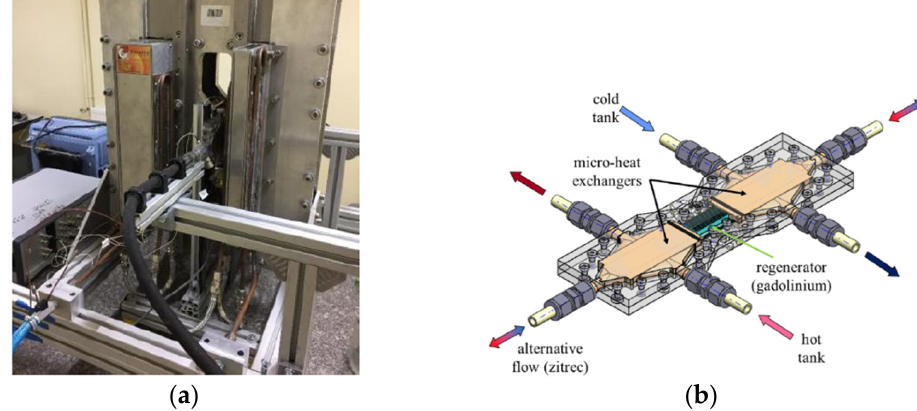
Figure 9. ( a ) Experimental device and ( b ) schema of the regenerator module [19,27]. Chaudron et al. (2016) [50] developed a rotary device with very high performances. Indeed, a temperature range of 20 K for a cooling power of 15 kW was generated. To